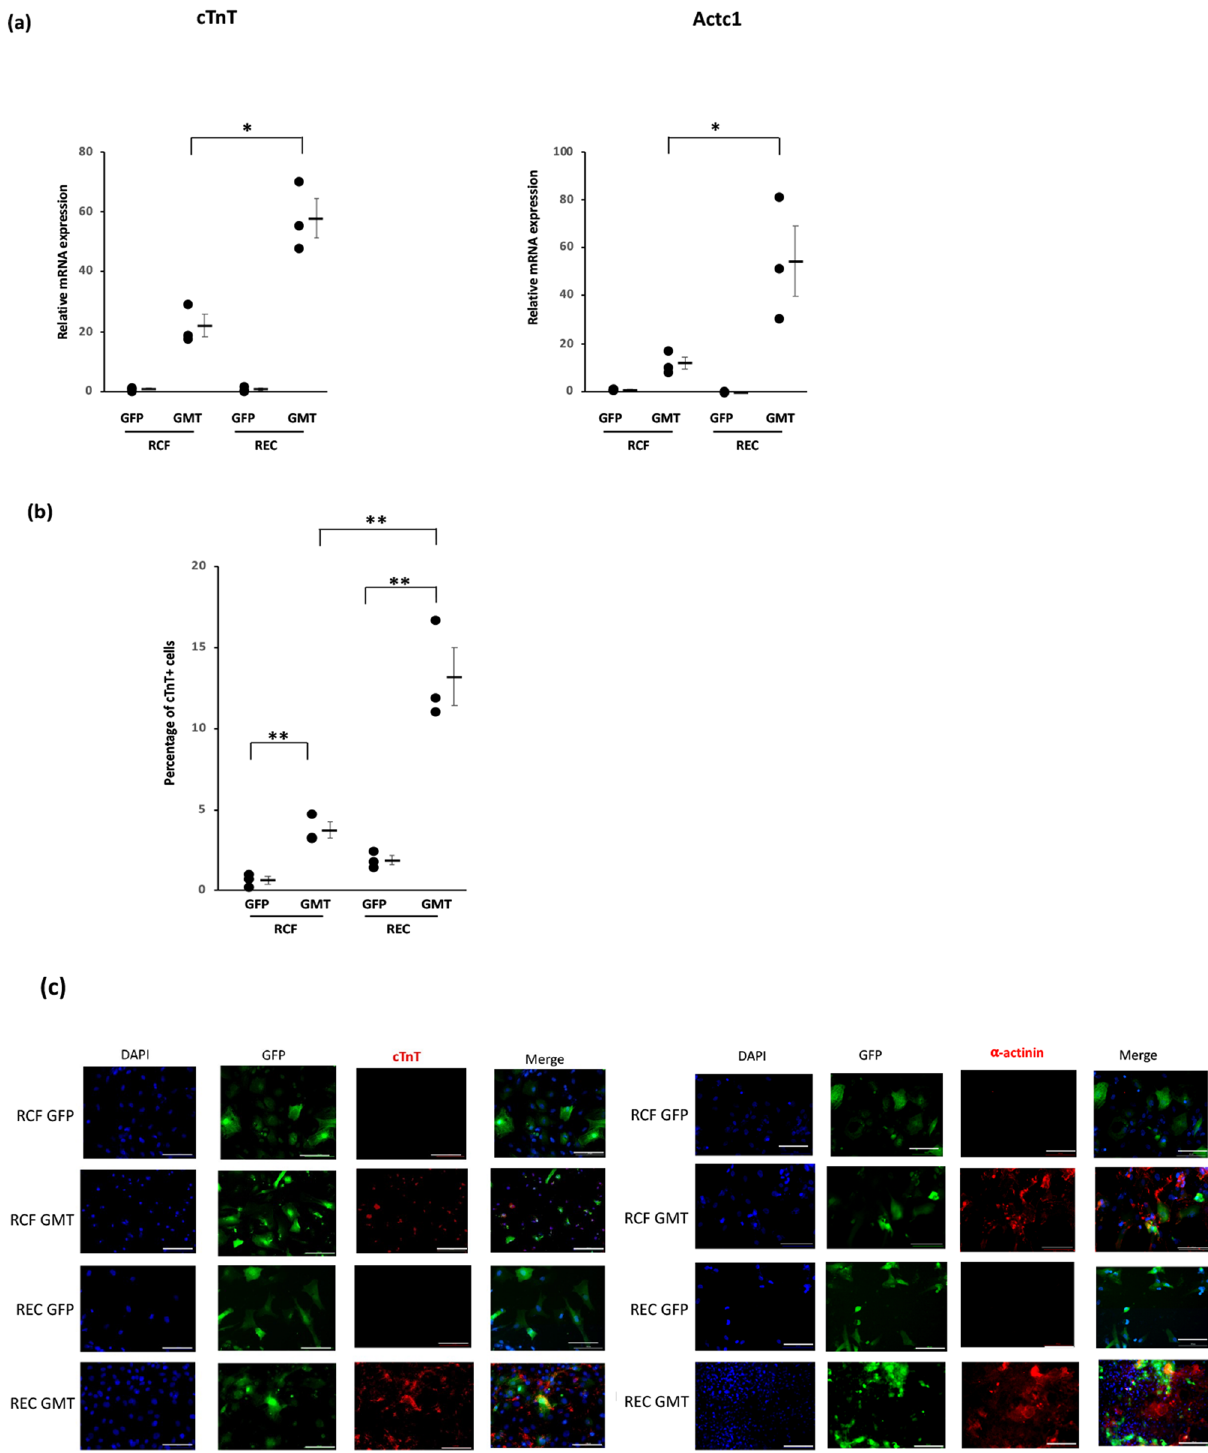
Figure 1. Endothelial cells are more efficiently reprogrammed into cardiomyocyte-like cells than are cardiac fibroblasts. Rat cardiac fibroblasts (RCF) and rat cardiac microvascular endothelial cells (REC) were treated with lentivirus encoding GFP or GMT (20 MOI) for 14 days (n = 3). ( a ) qPCR analysis demonstrating that cTnT and Actc1 expression was significantly increased in GMT-treated endothelial cells compared to GMT-treated cardiac fibroblasts (*p < 0.05). ( b ) Quantification of FACS data demonstrating an increased percentage of cTnT + cells in GMT treated endothelial cells compared to GMT treated cardiac fibroblasts (**p < 0.01) ( c ) Immunostaining demonstrating the increased prevalence of cTnT + and α-actinin + cells in GMT-treated endothelial cells compared to GMT-treated cardiac fibroblasts. Scale bar: 100